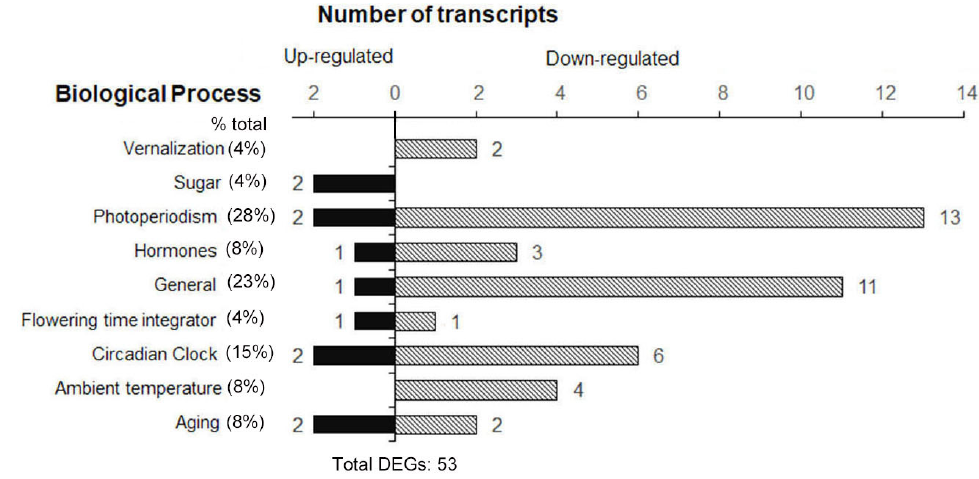
Figure 9. Functional classification of differential expression flowering genes (DEGs) in wild-type plants grown under the LD condition in space in comparison with their controls under the same condition on ground.